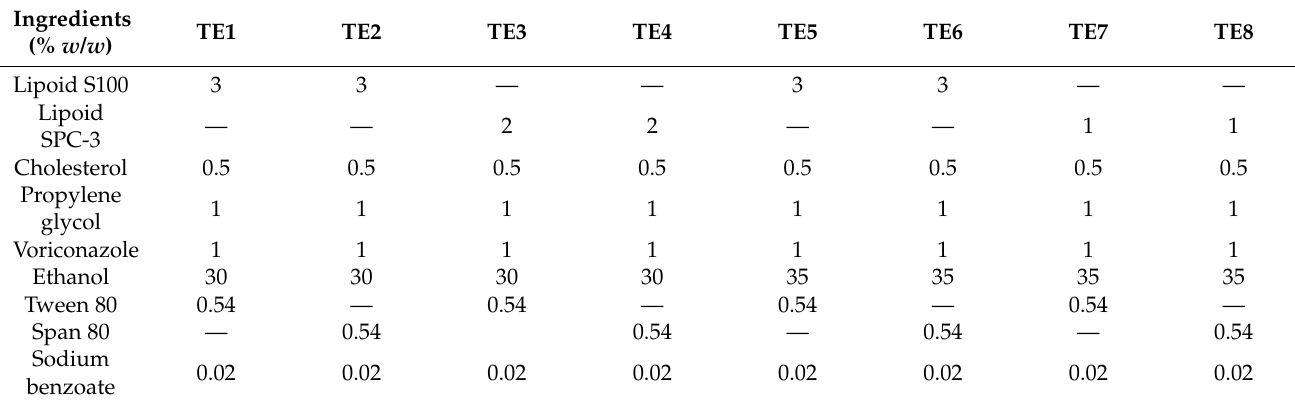
Figure 8. The schematic representation of the cold method. Table 6. Composition of transethosomes of voriconazole.